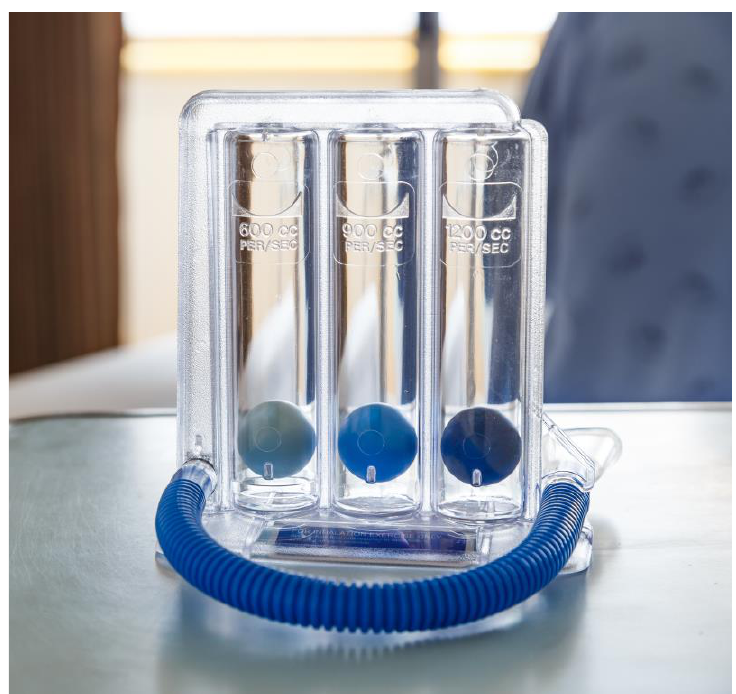
Figure 1. A Triflo II clinical incentive spirometer (image: iStock by Getty Images).